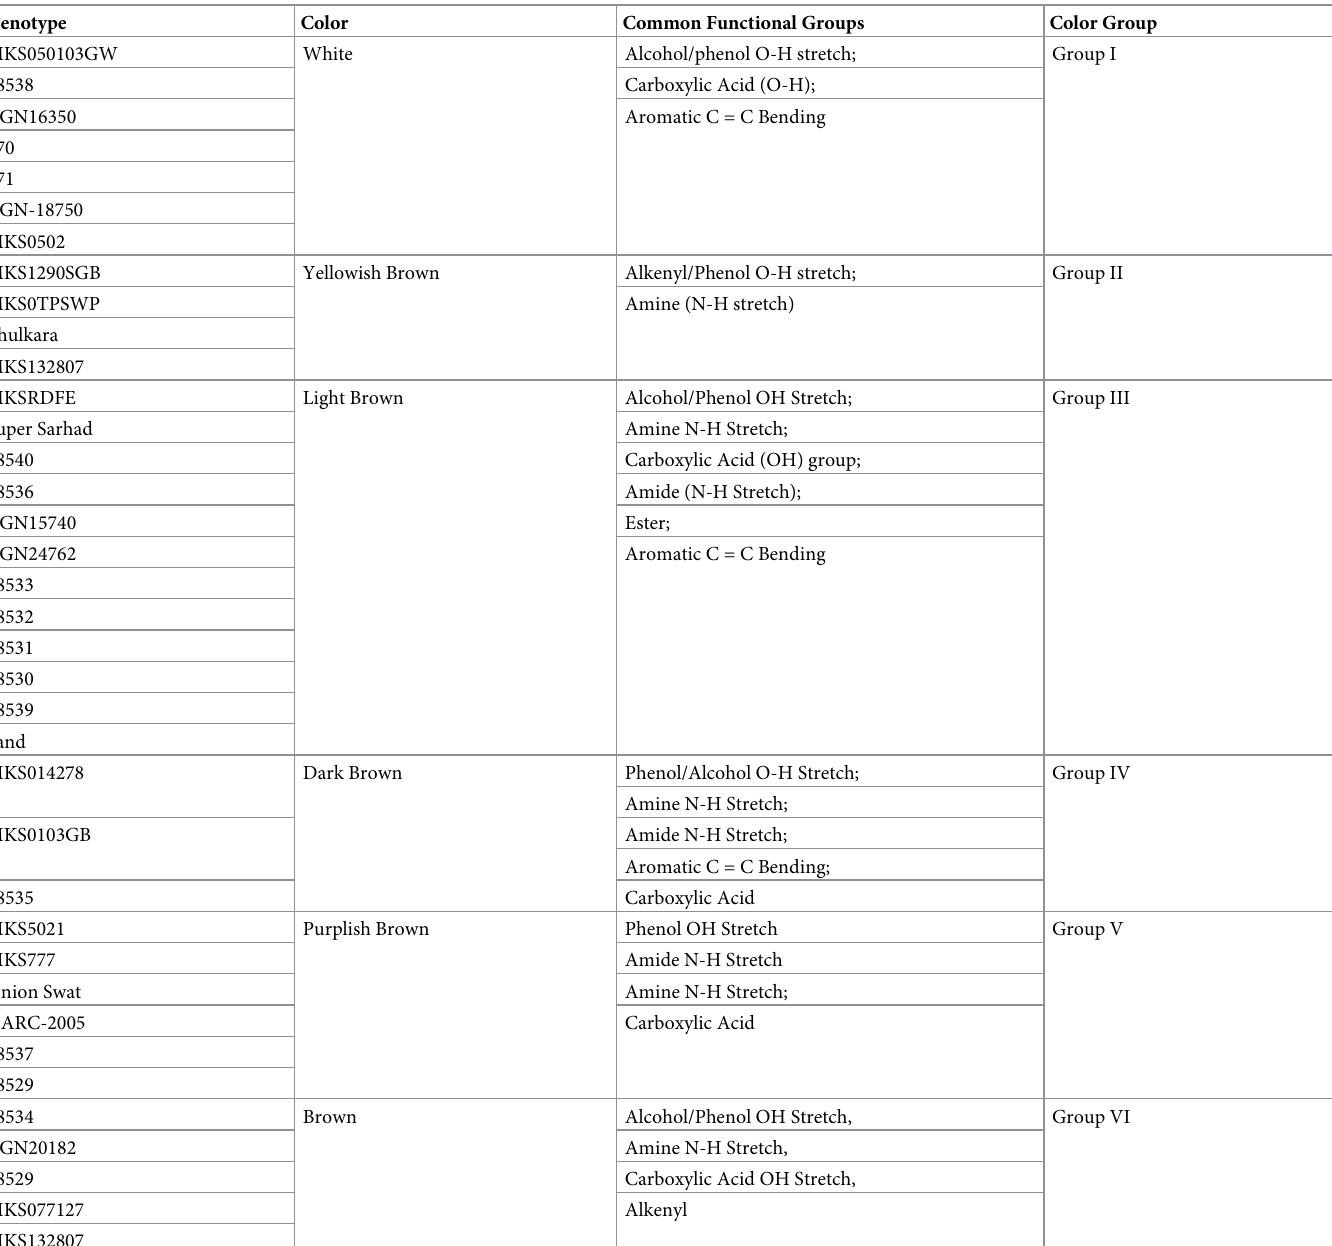
Table 2. Classification of genotypes based on common colors and functional